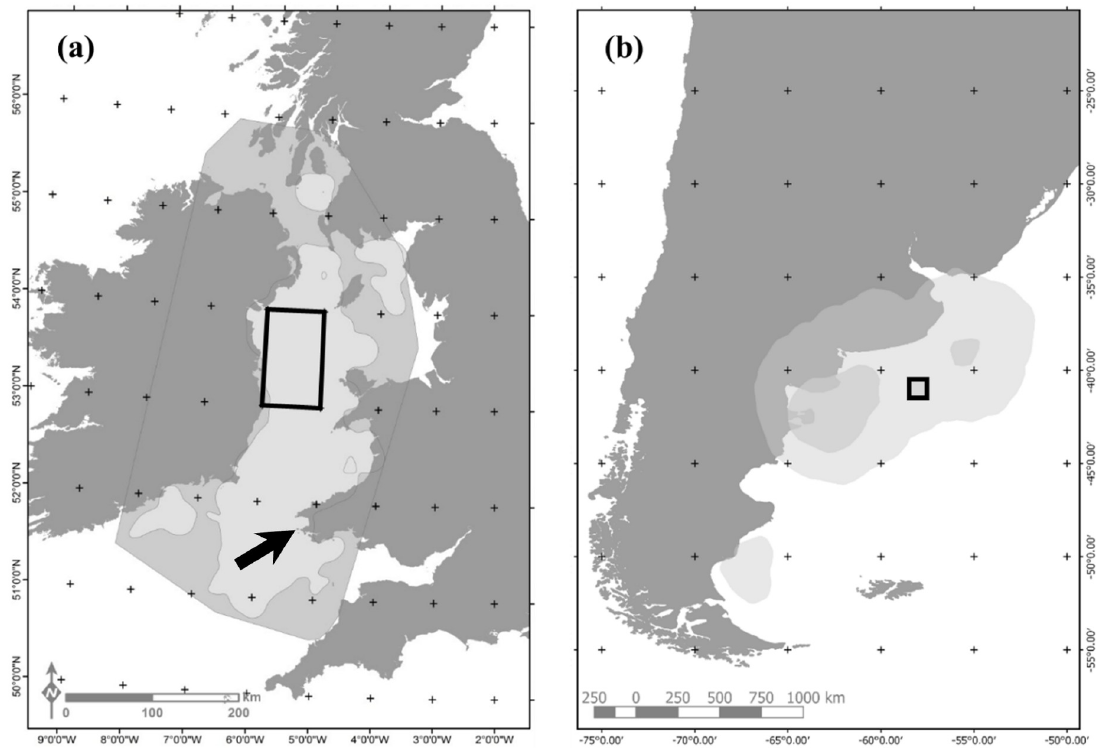
Fig 1. Key foraging areas used by Manx shearwaters breeding on Skomer Island, during the (a) breeding and (b) non-breeding season. Grey shading represents 90 and 95% kernel densities calculated from tracking of more than 100 individuals at an adjacent study plot on Skomer Island [17, 18], 50m from the Isthmus study plot. Black squares show the area used to extract localised environmental variables.